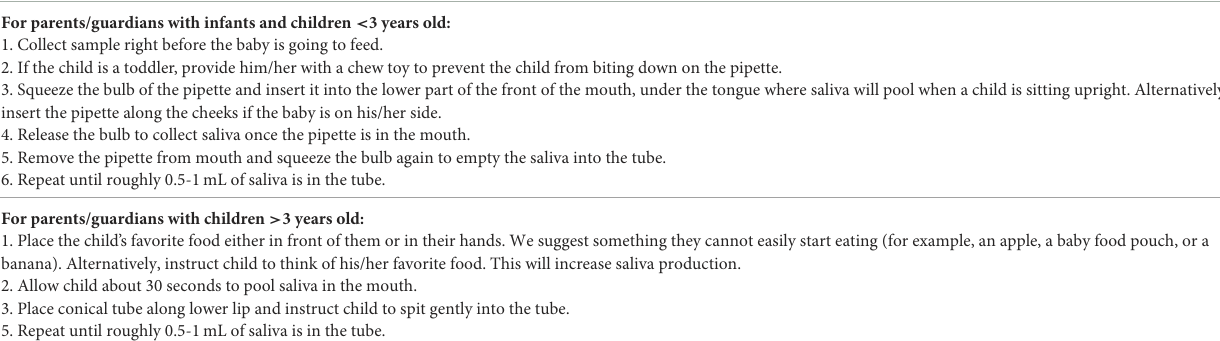
TABLE 1 Instructions for saliva